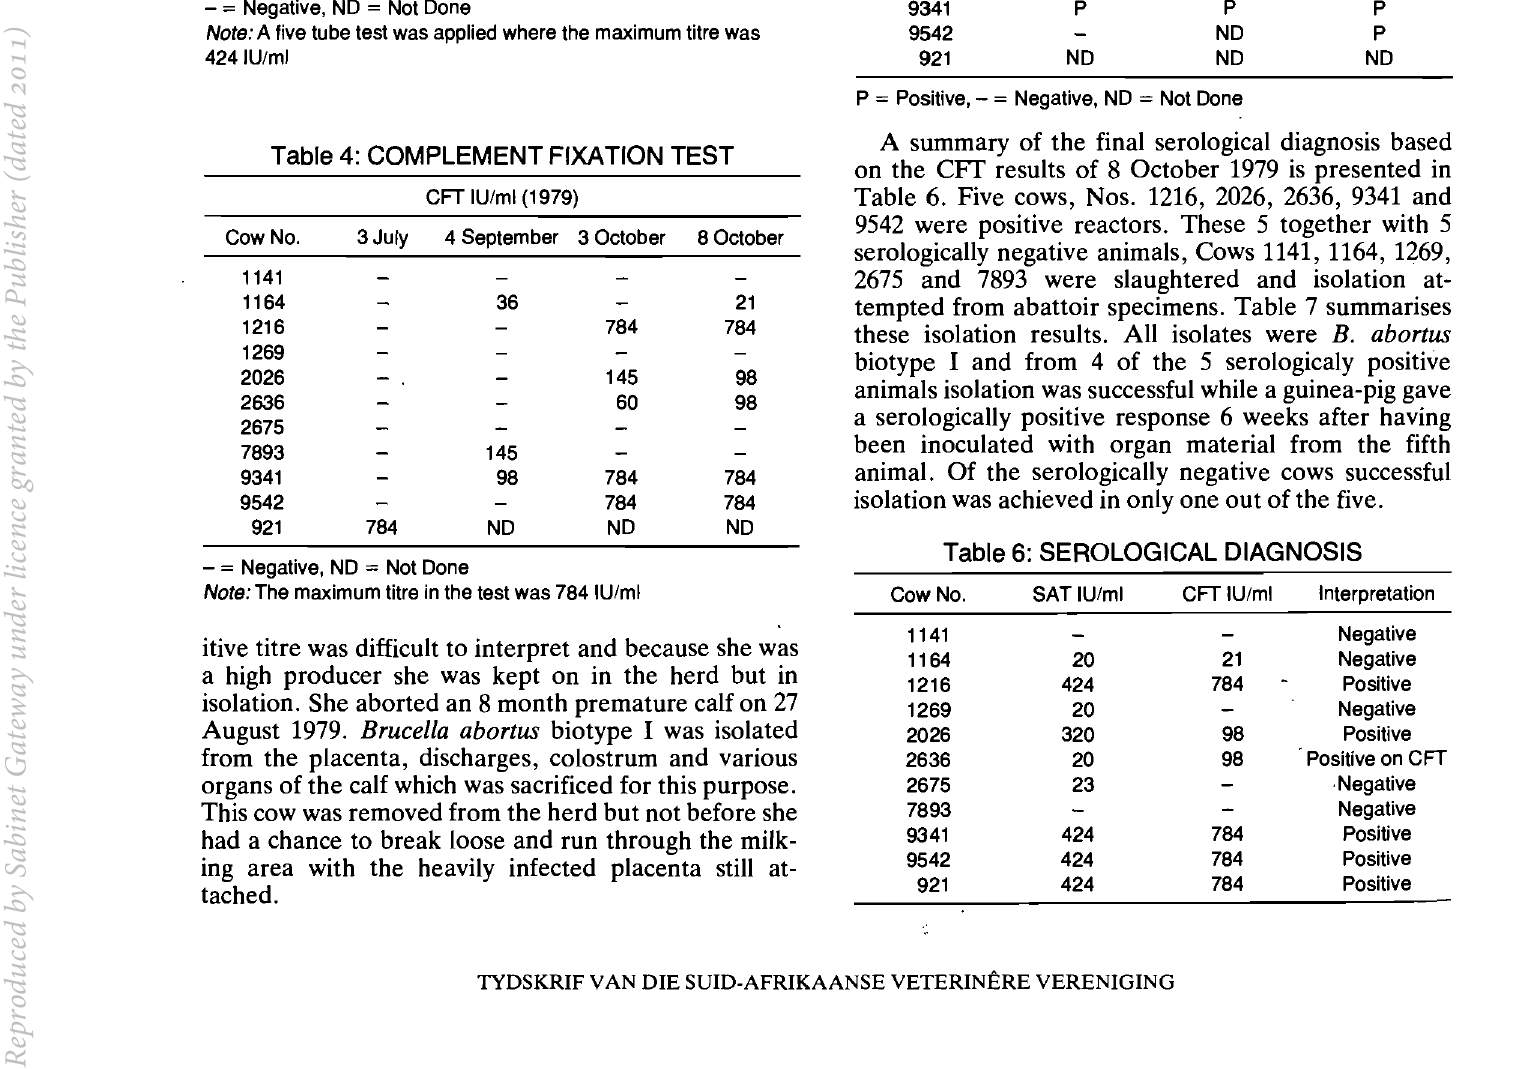
Table 4: COMPLEMENT FIXATION TEST